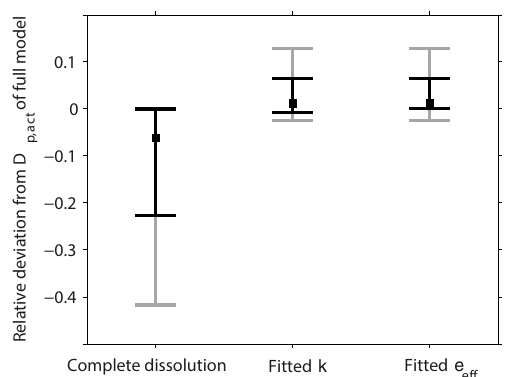
Figure 6. The performance of the simplified solubility representa- tions (see Table 1) in predicting the activation diameter for a given supersaturation as compared with the full model. The black bars depict the 25th and 75th percentiles and the grey bars the 10th and 90th